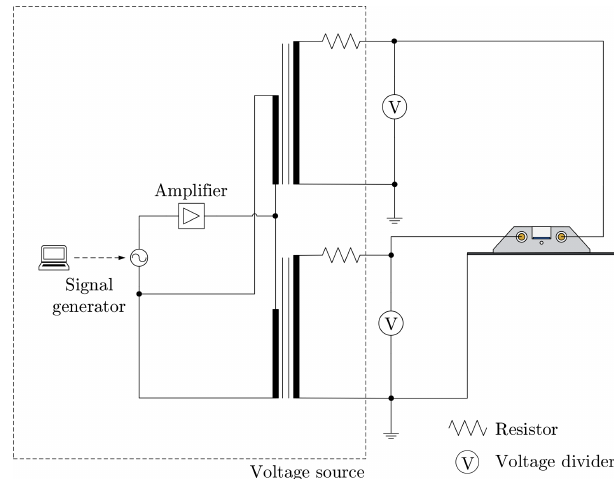
Figure 5. Schematic wiring diagram of the system for the power supply used to provide an alternating electric field. The voltage di- viders are used to measure the applied voltage. The dashed rectangle represents the voltage source and can be replaced according to the required type of electric